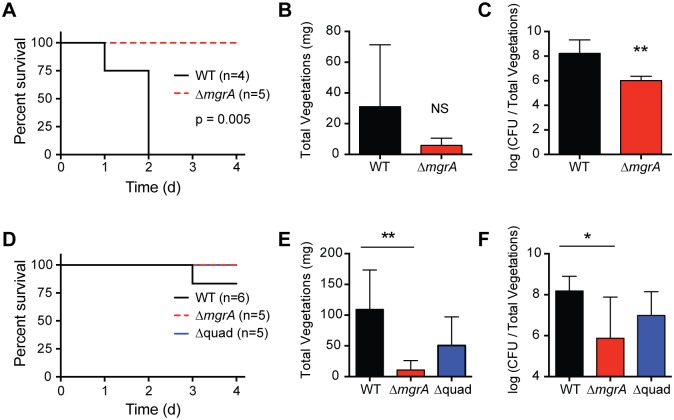

mgrA mutants are less virulent in a combined rabbit model of sepsis and endocarditis.Prior to infection, aortic valve damage was induced by temporary placement of plastic catheters in the carotid artery. Catheters were removed and rabbits were infected intravenously with either strain 502a (A-C), or strain MW2 (D-F). WT strains were compared to the mgrA single mutant, and for MW2 the mgrA ebh sraP sasG quadruple mutant (Δquad) was also tested. Rabbits were monitored for up to four days, and survival (A, D), total heart valve vegetation weights (B, E), and CFUs per total vegetations (C, F) were monitored. Statistical significance was determined using a log-rank (Mantel-Cox) test (survival), or two-tailed t test (vegetation weights and CFU counts). ** p<0.005, * p<0.05, NS not significant.